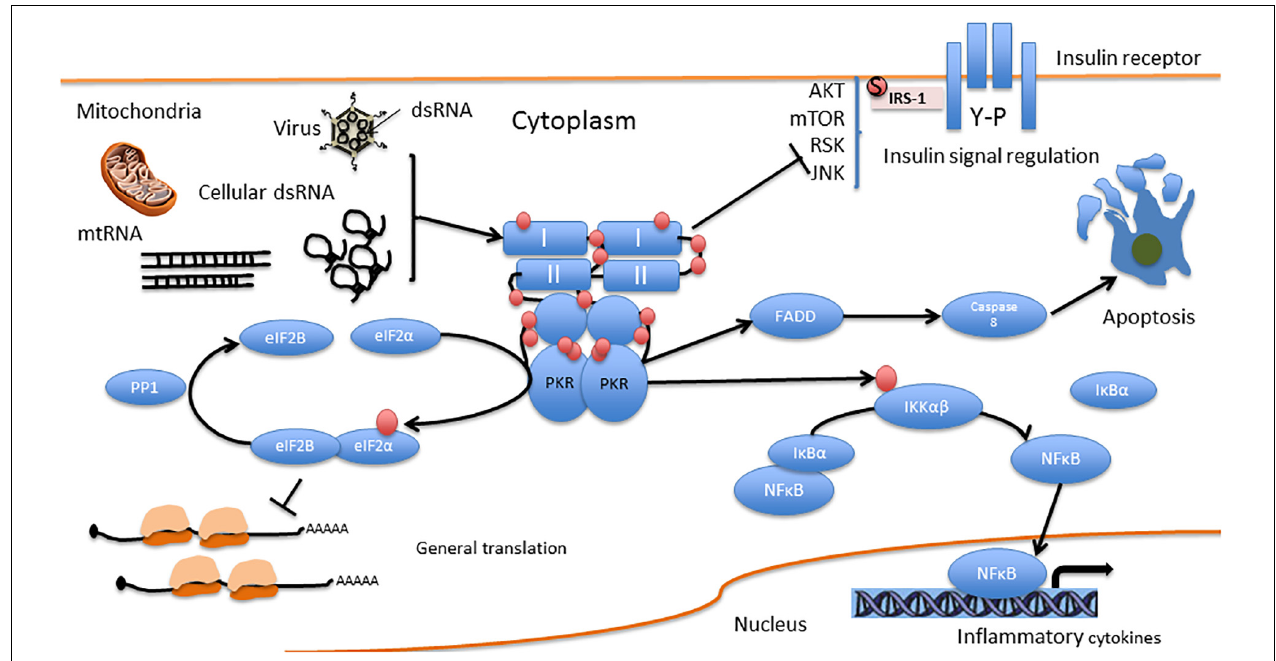
FIGURE 3 | PKR direct interactions. I and II are the dsRNA binding domains. Red circles represent phosphorylation